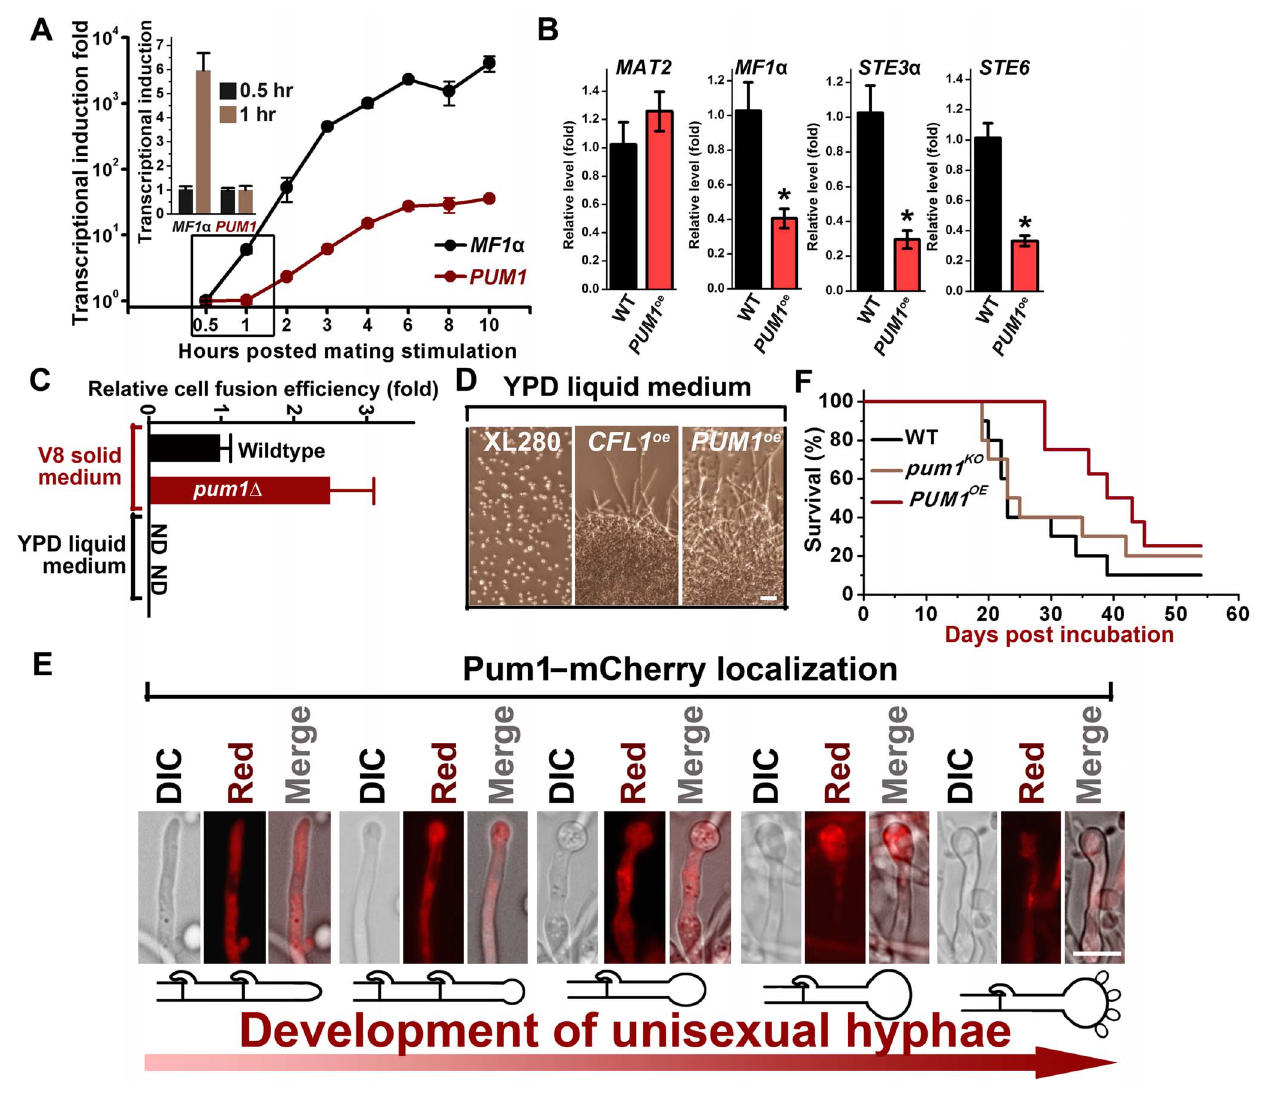
Figure 3. Pum1 controls filamentation but not early mating processes. (A) Transcriptional dynamics of MF1 a and PUM1 during mating. The RNA from the a + a mixture co-cultured on V8 agar at 22 u C in the dark at indicated time points was subjected to the transcriptional analysis by real time PCR. There was a delay in the transcriptional induction of PUM1 compared to that for the pheromone gene MF1 a . (B) Overexpression of PUM1 did not increase the transcript level of the genes in the pheromone pathway. The expression level of the corresponding genes in the wildtype strain XL280 grown under the same condition was arbitrarily set as 1 for comparison. (C) Pum1 is modestly inhibitory for cell fusion. The a and a partners from wildtype strains or the pum1 D mutant marked with different auxotrophic markers were co-cultured on V8 agar or YPD liquid medium for 22 hours at 22 u C in the dark. The cocultures were then collected, washed, and plated onto YNB minimal medium to select for fusion products. The cell fusion efficiency of the wildtype coculture was arbitrarily set as 1 for comparison. (D) Overexpression of PUM1 and CFL1 are sufficient to trigger filamentation even under mating-suppressive conditions. The wildtype strain, the P CTR4-2 -PUM1 strain, and the P CTR4-2 -CFL1 strain were grown in the YPD liquid medium. Filamentation and cell aggregation (cell-cell adhesion) were observed in the CFL1 oe and PUM1 oe strains but not in the wildtype strain. Scale bar: 20 m m. (E) The P GPD1 -PUM1 strain was significantly less virulent in a murine intranasal inhalation infection model compared with the wildtype strain XL280 and the pum1 D mutant ( P , 0.01). (F) Pum1-mCherry is expressed at a relatively constant level throughout hyphal growth and basidial development ( . 40 hyphae for each stage were examined). Scale bar: 10 m m. doi:10.1371/journal.ppat.1004185.g003 their filamentation in a paracrine manner [2]. Thus an Furthermore, some of the Cfl1 proteins were correctly cleaved impairment of Cfl1’s secretion or its release could lead to deficient into a smaller product in the pum1 D mutant as in the wildtype filamentation, a phenotype observed in the pum1 D mutant. To strain (Figure 4D). Taken together, these observations suggest that assess the impact of the deletion of PUM1 on the secretion and Pum1 is not critical for the expression, secretion, or the processing releasing of Cfl1 from the cell wall, we employed the colony of Cfl1. Because the pum1 D cfl1 D double mutant displayed a much immunoblot assay, which detects released proteins from an intact more severe defect in aerial hypha development than either of the colony [2]. As shown in Figure 4C (bottom panel), released Cfl1 single mutant alone (Figure 4A), Pum1 and Cfl1 represent two was not detected in the znf2 D mutant while the deletion of PUM1 parallel branches modulating Znf2-mediated filamentation pro- only modestly reduced the level of released Cfl1 proteins. gram.